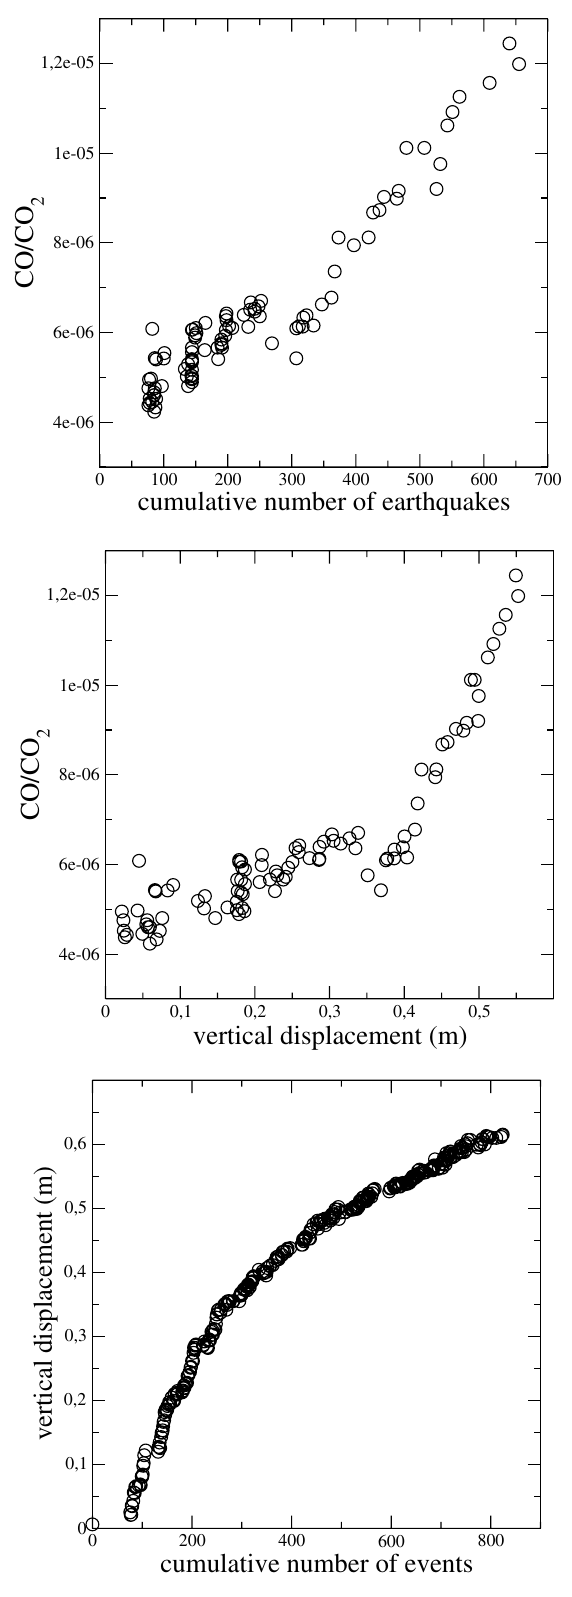
Figure 7. CO/CO 2 fumarolic ratio versus the cumulative number of earthquakes, CO/CO 2 fumarolic ratio versus the vertical displacement and the vertical displacement versus the cumulative number of earthquakes. In all cases the correlation between the variables appears to be very clear independently of the functional form of the